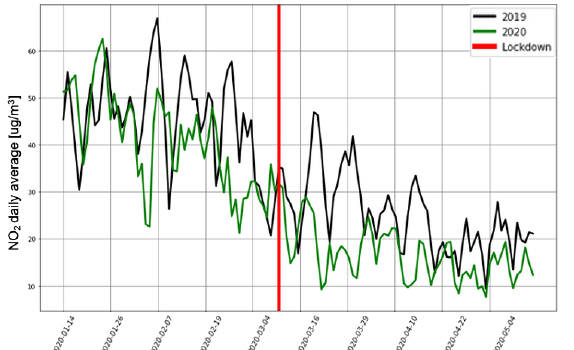
Figure 2. Comparison of the NO 2 daily averages computed from the ARPA Lombardia sensors in the study periods.